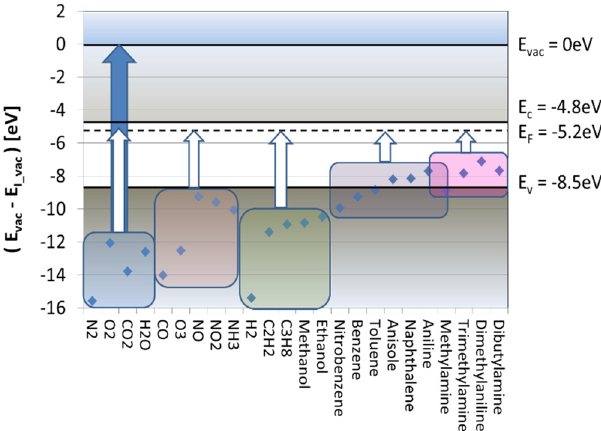
Figure 15. Free-space ionization energies E I _ vac of selected molecules [20] in relation to the vacuum energy E vac and the conduction and valence band edges and the Fermi energy in SnO 2 . Blue and white arrows: free-space and first-order surface ionization energies. Colored rectangles denote different groups of analytes.